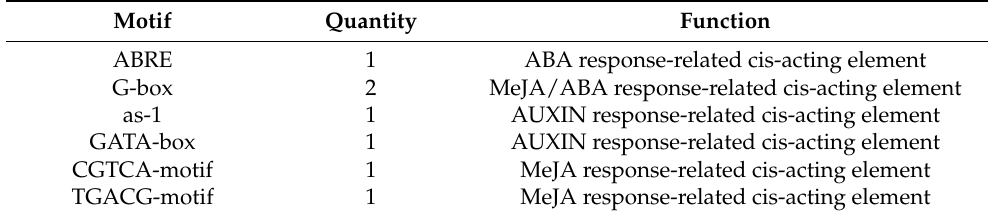
Table 2. Analysis of hormone-related cis-acting elements in the promoter region.